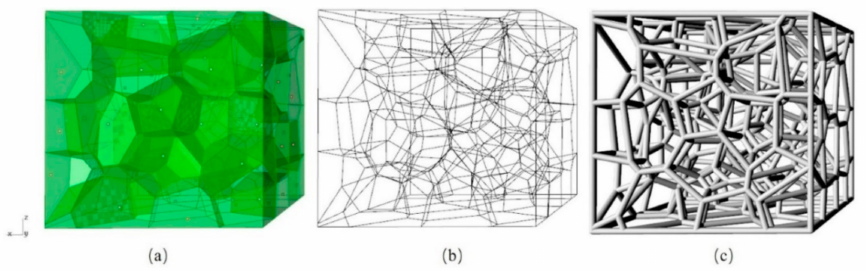
Figure 1. Design process of random Voronoi structure: ( a ) randomly distributed points and polyhe- dral cells; ( b ) frame lines of random Voronoi structure; ( c ) random Voronoi structure.